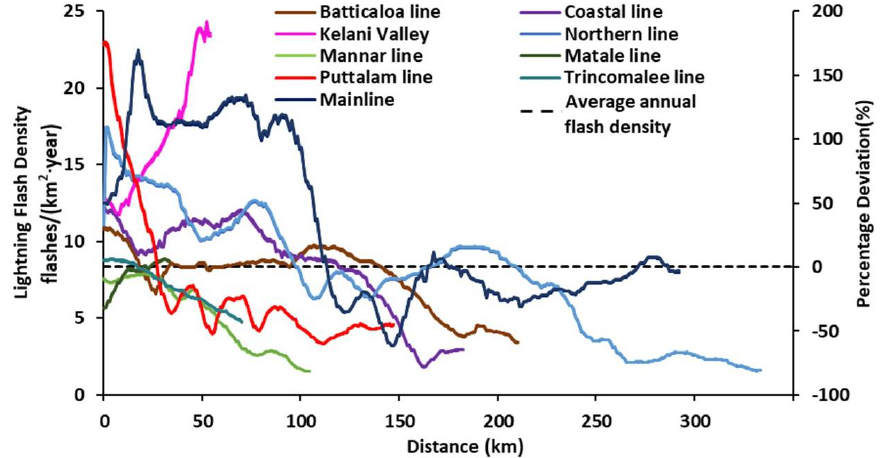
Figure 5. Variability of lightning flash density along with the railway network at each point of 1 km distance and percentage deviation of lightning flash density relative to the annual average flash density of Sri Lanka along with the railway network of Sri Lanka during the period of 1998 – 2014.